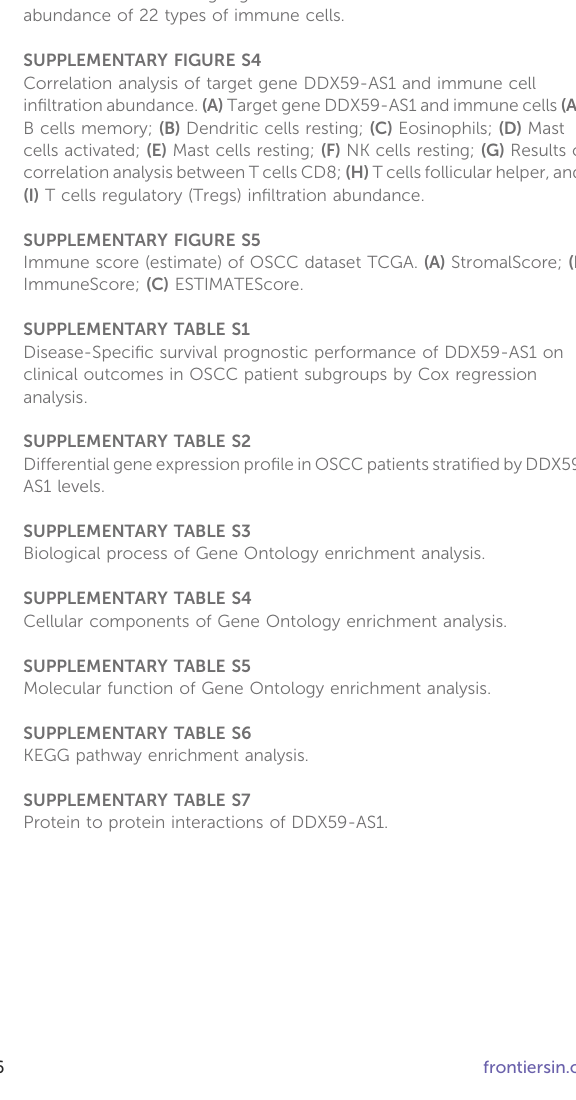
AS1 levels. SUPPLEMENTARY TABLE S3 Biological process of Gene Ontology enrichment analysis. SUPPLEMENTARY TABLE S4 Cellular components of Gene Ontology enrichment analysis. SUPPLEMENTARY TABLE S5 Molecular function of Gene Ontology enrichment analysis. SUPPLEMENTARY TABLE S6 KEGG pathway enrichment analysis. SUPPLEMENTARY TABLE S7 Protein to protein interactions of